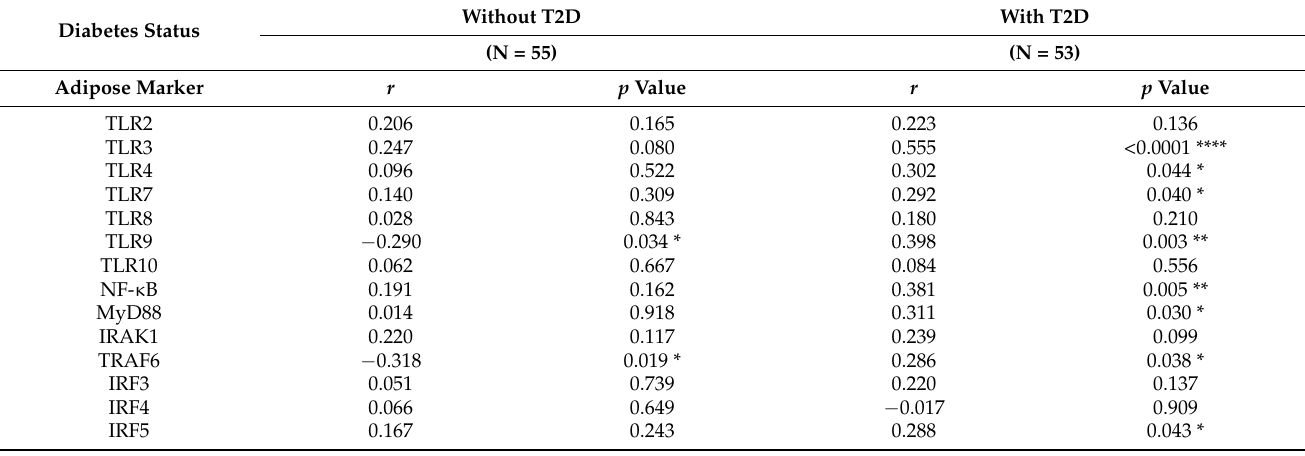
Table 4. Spearman’s correlation analysis of adipose gene expression of SRA1 with TLRs, their signaling mediators, and IRFs in individuals with/without T2D.